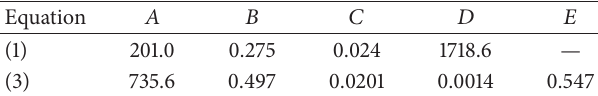
Table 9: Coefficients in (1) and (3) determined for CuCr alloy using inverse analysis with the metamodel for the UC and PSC tests.